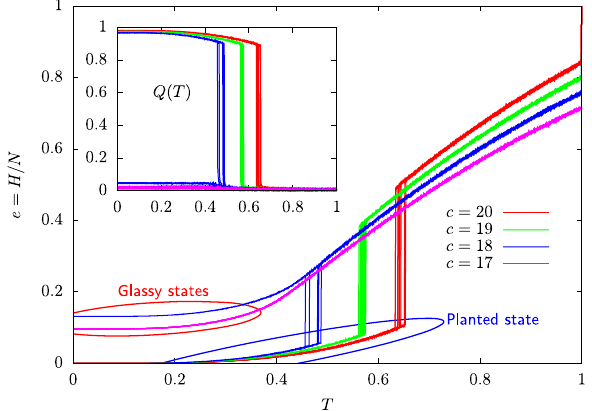
FIG. 2. The energy density as a function of the temperature in simulated annealing for planted coloring with q ¼ 5 , N ¼ 10 5 , and dT ¼ 10 − 7 . For each value of the mean degree c , we show the results for ten different samples. For c ≲ 18 , SA does not find the planted solution and gets trapped in glassy states. Inset: overlap with the planted configuration as a function of the temperature (same parameters as in the main